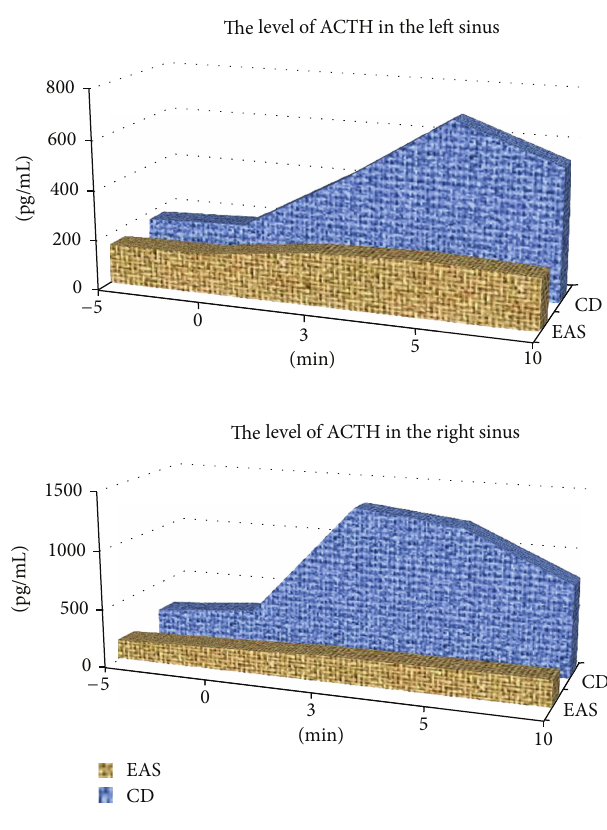
Figure 3: Dynamics of ACTH concentration based on selective blood sampling from petrosal sinuses in the desmopressin stimulation test in patients with Cushing’s disease and ectopic ACTH secretion. Table 3: Distribution of pituitary and extrapituitary ACTH-secreting tumours based on the results of immunoexpression of tropic hormones. Ectopic ACTH-secreting tumours 𝑃,𝜒 2 Corticotropinomas, Hormone expression 𝑛 = 46 IHC characteristics